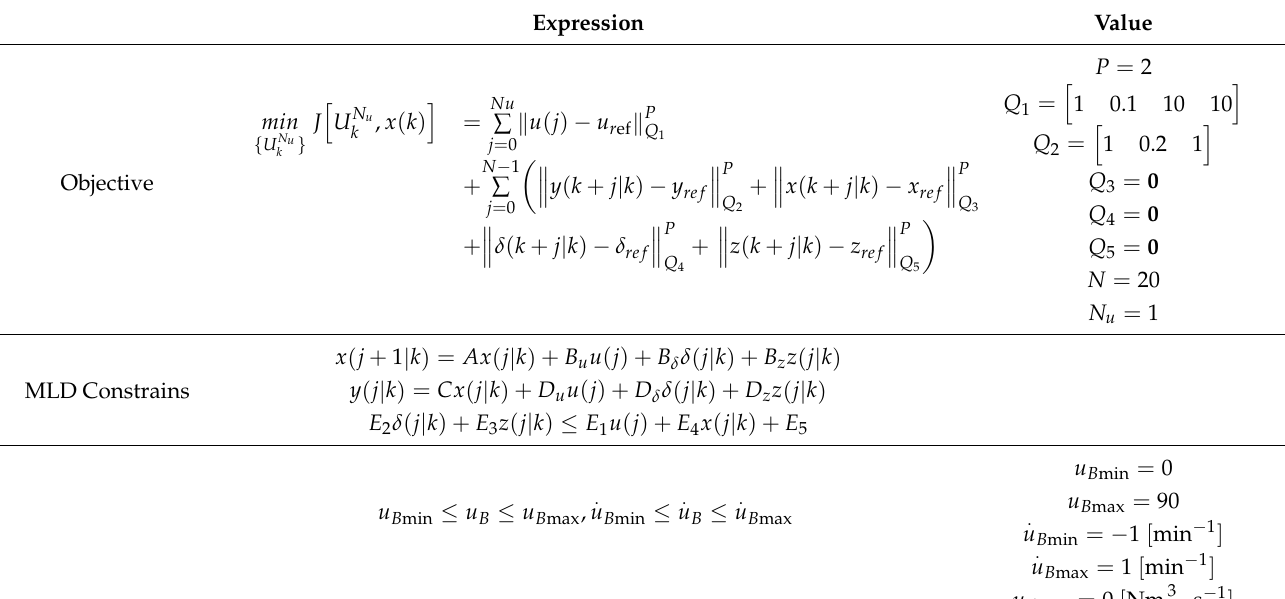
Table 4. The related information of coordinated system predictive